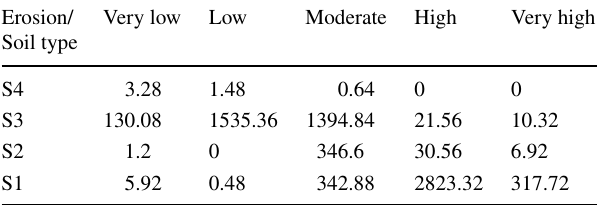
Table 12 Relationship of soil erosion and topographic wetness